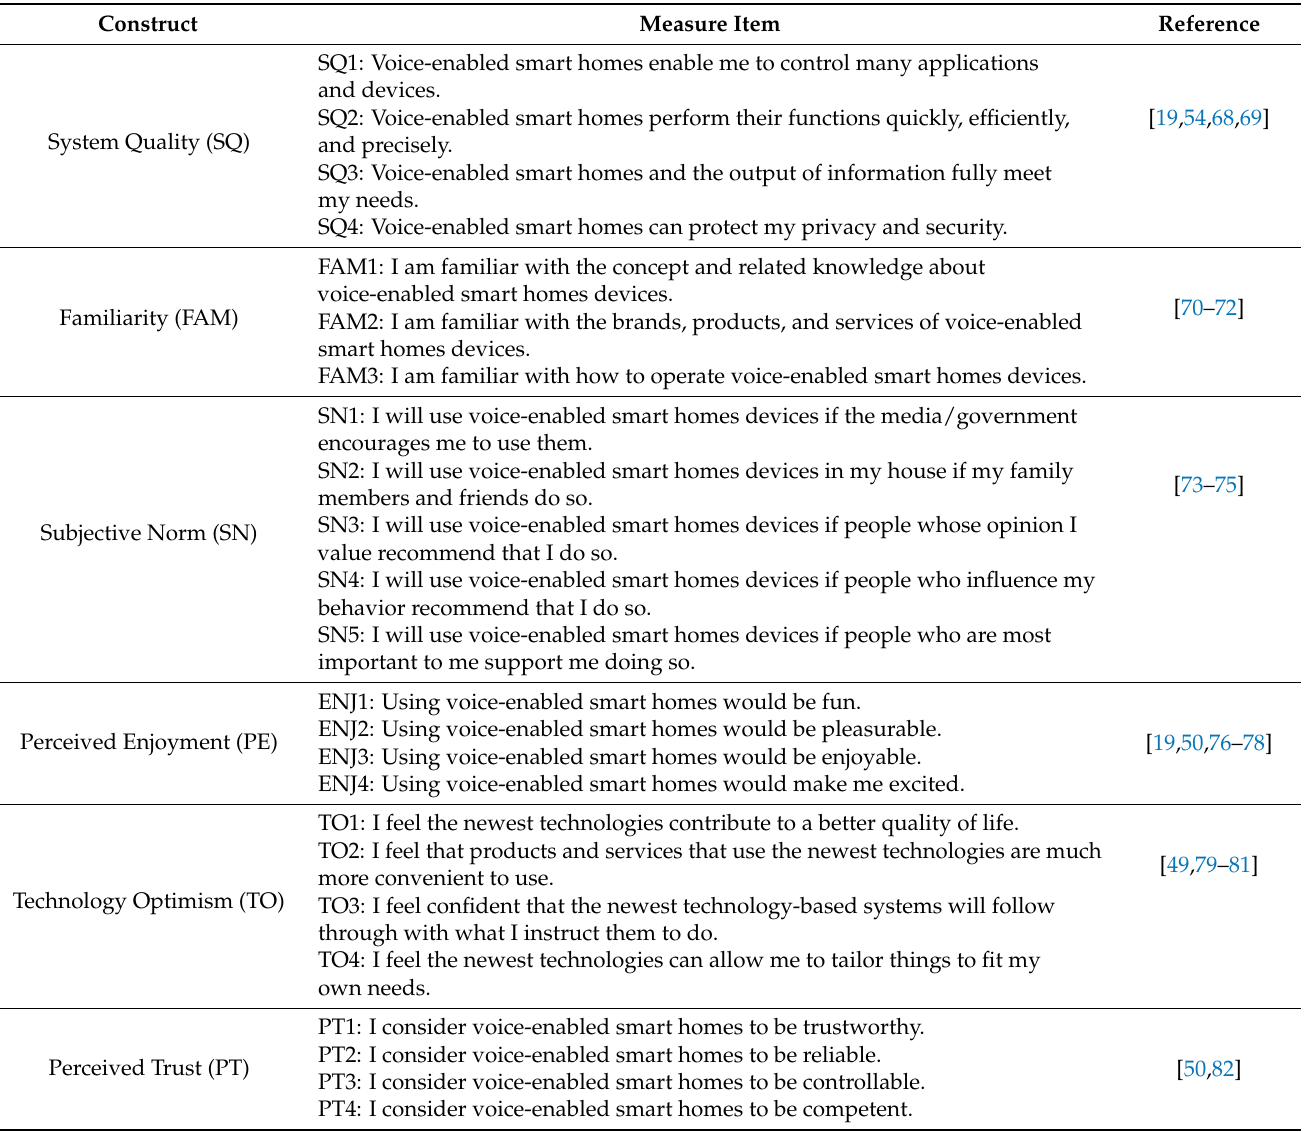
Table 1. Constructs and measurement